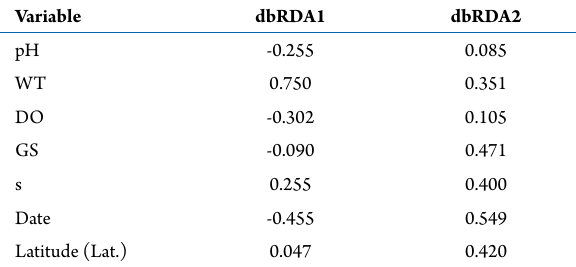
Figure 6. Redundancy Analysis (RDA) ordination plot for most abundant harpacticoid species and environmental variables (Abbreviations: A. par.: Ameira parvula ; E. soy.: Ectinosoma soyeri ; K. kli.: Klieonychocamptus kliei ; K. pon.: K. ponticus ; L. eul.: Leptomesochra eulitoralis ; M. nor.: Microsetella norvegica ; S. ang.: Sarsamphiascus angustipes Table 7. Correlation coefficients in the dbRDA ordination for the tested variables and the first two axes.